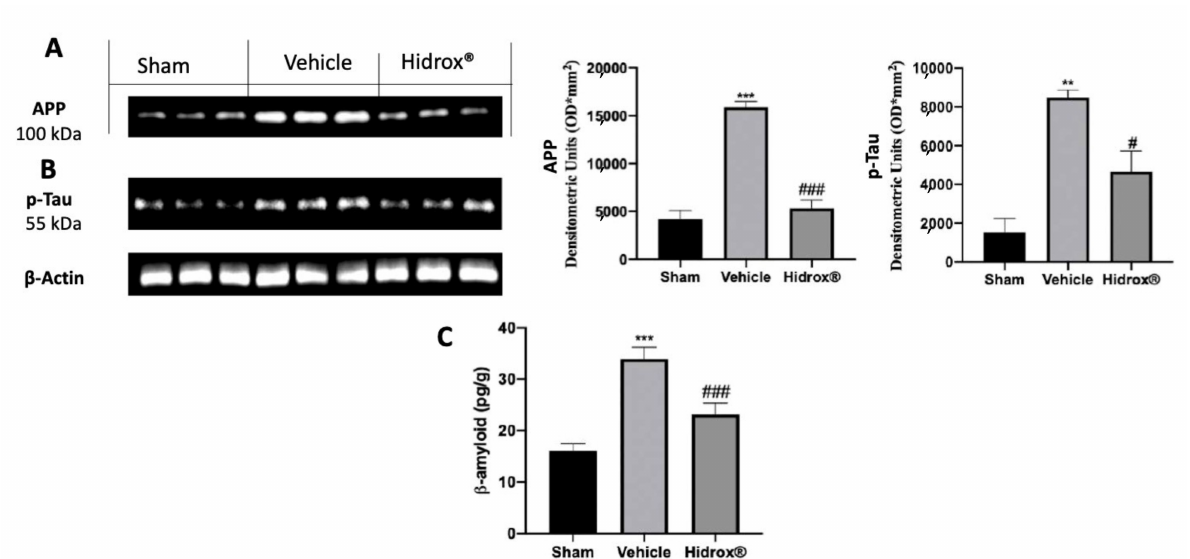
Figure 5. Hidrox ® administration reduced AD markers. Western blot analysis of hippocampus p-Tau ( A ) and APP ( B ) expression and β -amyloid levels ( C ). For the analyses, n = 5 animals in each group were employed. The results were analyzed by one-way ANOVA followed by a Bonferroni post-hoc test for multiple comparisons. Densitometric analysis of representative western blot analysis of APP expression ( A ): F (2,6) = 62.56, Densitometric analysis of representative western blot analysis of p-Tau expression ( B ): F (2,6) = 20.40, β -amyloid levels ( C ): F (2,12) = 16.43. A p -value of less than 0.05 was considered significant. # p < 0.05 vs. vehicle, ** p < 0.01 vs. sham, *** p < 0.001 vs. sham, ### p < 0.001 vs.